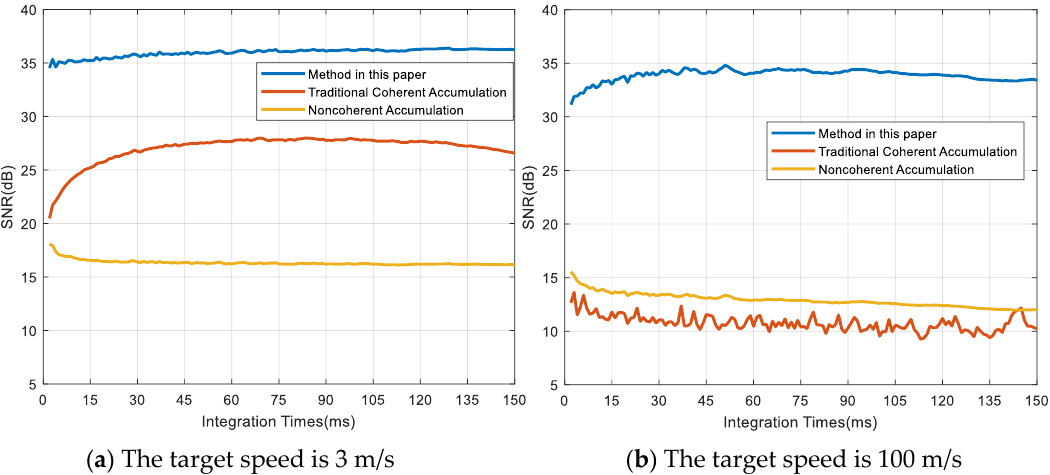
Figure 21. SNR of three methods.